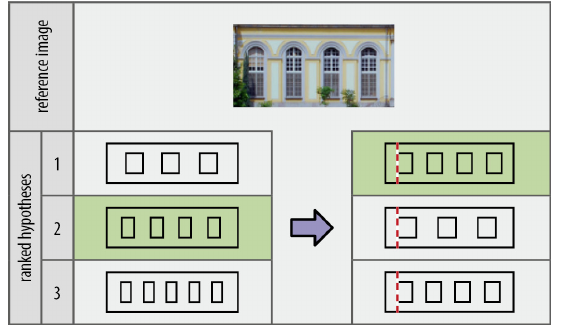
Figure 10: The impact of additional observations on the certainty of model hypotheses. Certainty is increased by considering a sin- gle observed embrasure (Loch-Dehbi and Pl¨umer, 2015). This approach can be adapted for assessing and improving the quality of electric line